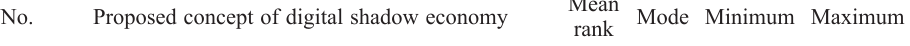
Mean Mode Minimum rank